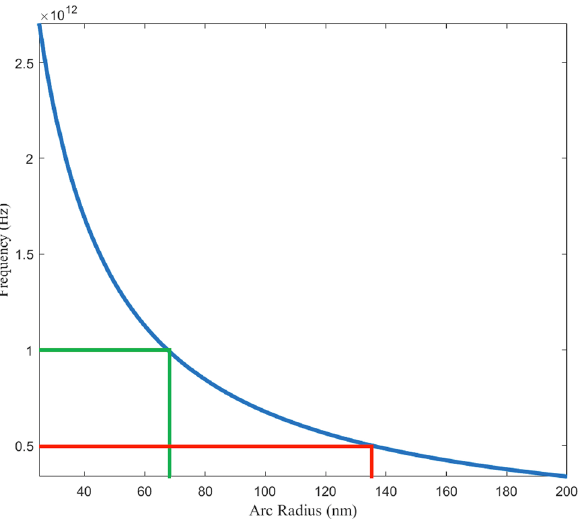
Figure 2. Trendline of emitted frequency vs. arc radius for a rotating dipole with a tangential velocity of v sat = 4.25 × 10 7 cm/s . The target frequencies of 0.5 THz and 1.0 THz require an arc radius of 135 nm and 67 nm